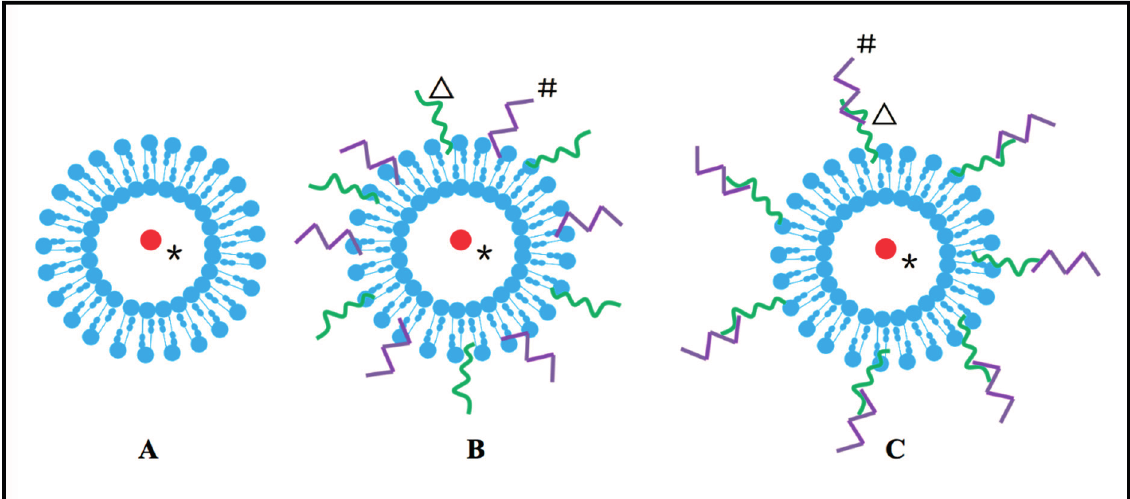
Figure 2. CPPs-modified liposome. ( A ) The original liposome; ( B ) The CPPs